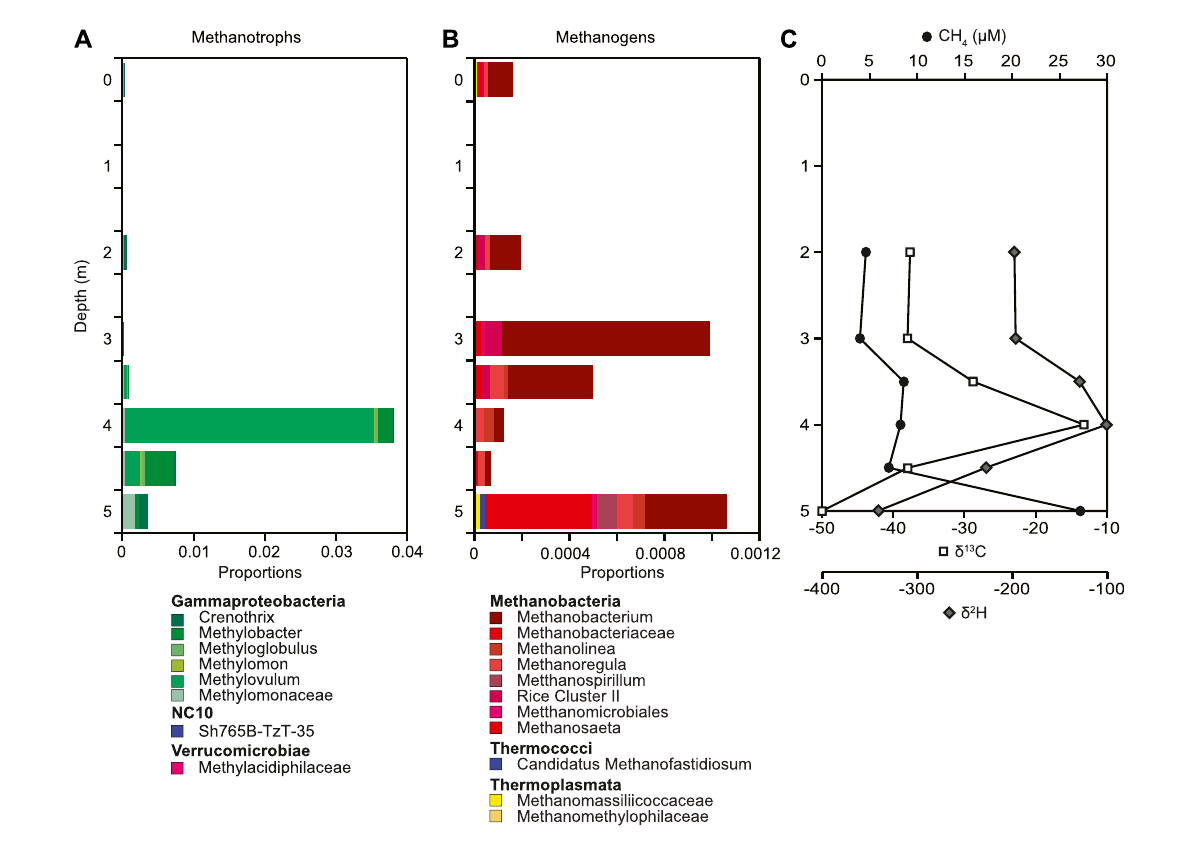
FIGURE 5 Depth pro fi les of (A) putative methanogen relative abundances, (B) putative methanotroph relative abundances based on 16S rRNA gene sequences, aswellas (C) concentrationandstableCandHisotopecompositionofdissolvedmethane downthewater column.ThenumberofASVs included in each taxonomic group is included with the number given after the taxonomic name. If no number is given, the group only contains one